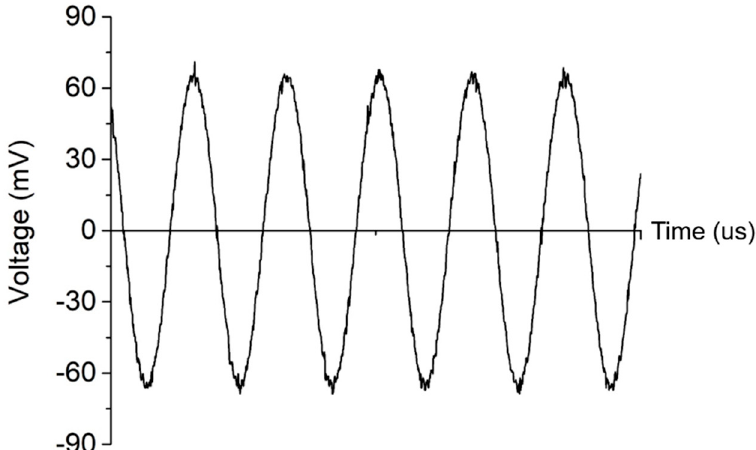
Figure 6. A filtered output voltage after differential amplification of the WB output voltages V A and V B with a gain of 40 dB.